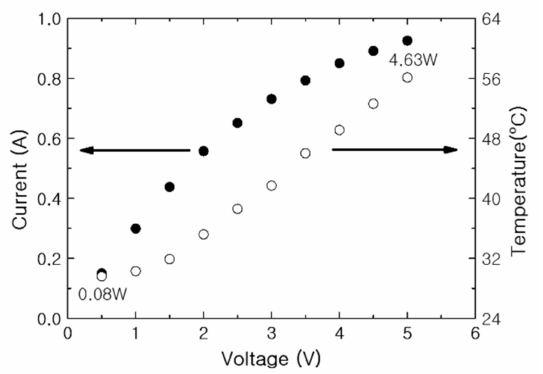
Figure 10. Current and temperature of the PTC-SHT according to applied voltage.